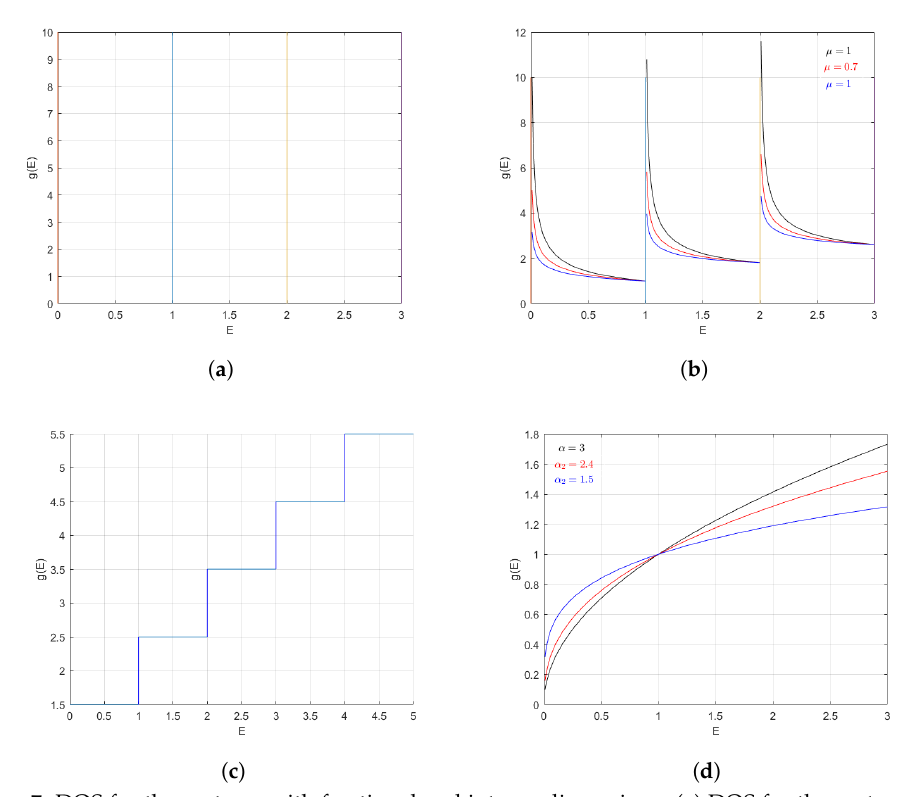
Figure 7. DOS for the systems with fractional and integer dimensions. ( a ) DOS for the system with dimension 0; ( b ) DOS for the system with dimensions 1, 0.7 and 0.5; ( c ) DOS for the system with dimension 0; ( d ) DOS for the system with dimensions 3, 2.4 and